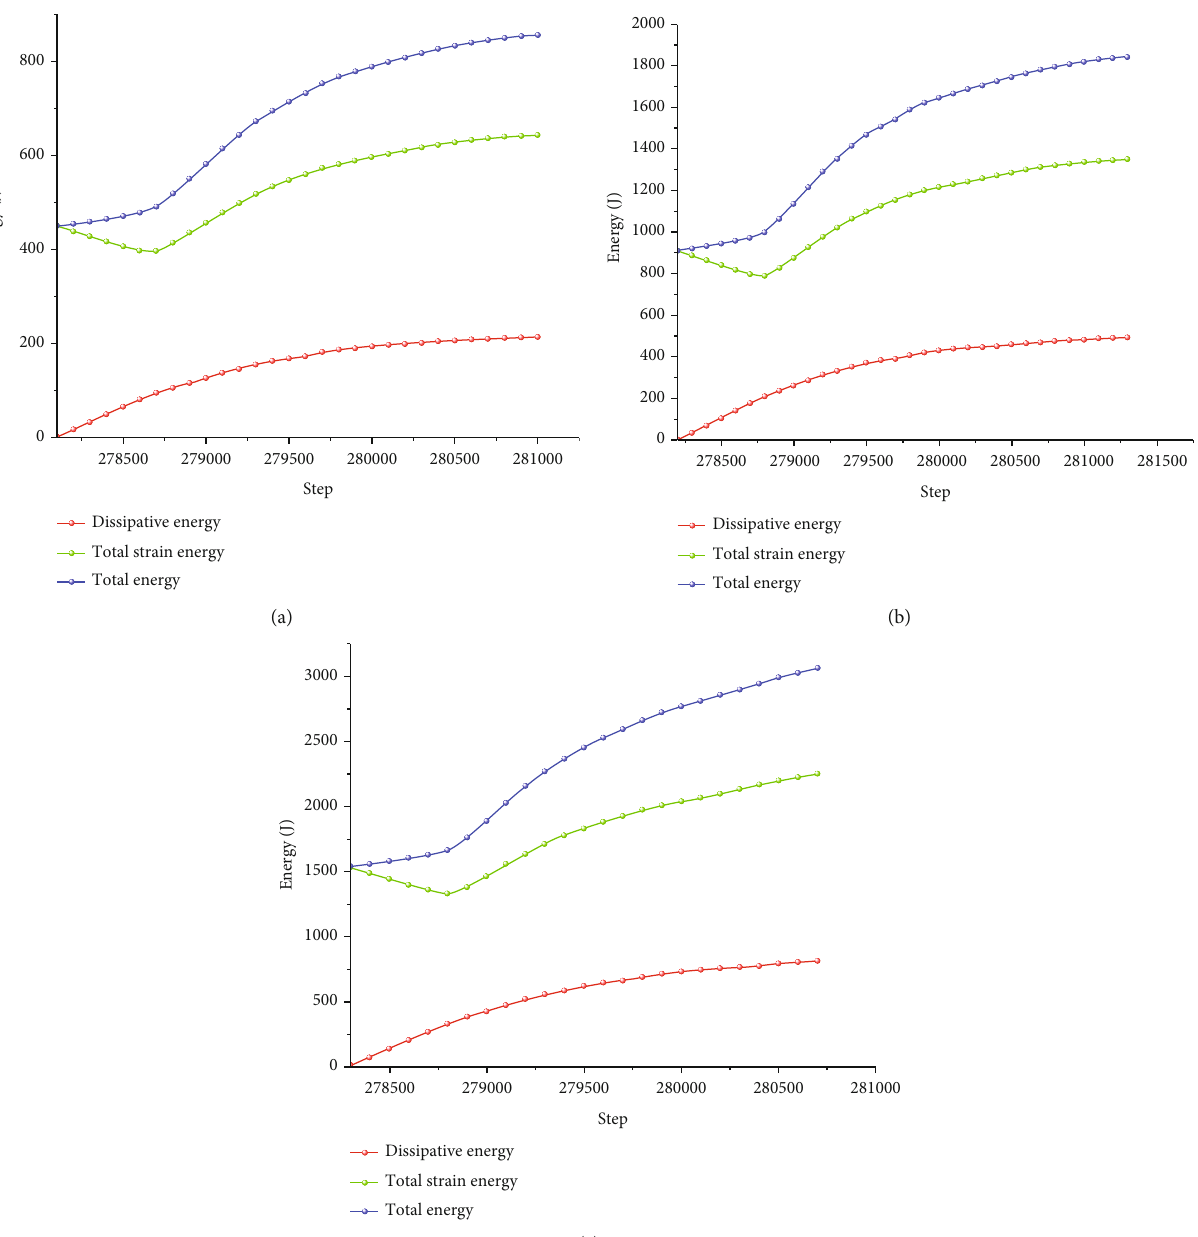
Figure 12: Energy change diagrams under partial hydrostatic pressure combination conditions. (a) σ MPa . (c) σ V = σ H = 80 MPa